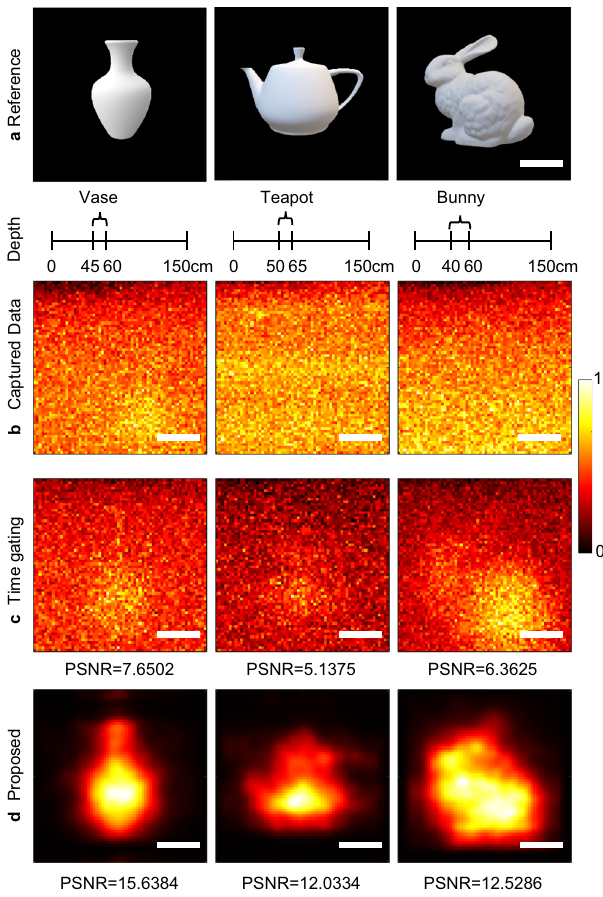
Fig. 6 Comparisons on reconstructing Lambertian objects with complex structures in the fog. a References of 3D Lambertian objects used in this experiment. The total depth of the fog chamber and object depths are marked in the scale below each picture. Taking the ‘ Vase ’ in the fi rst column as an example, the total depth of the fog chamber is 150 cm and ‘ Vase ’ is located at a depth range of 45-60 cm. All scale bars indicate 10 cm. b Images directly captured by the ultrafast detector; c Time-gated results which are taken by combining multiple time-shift bins corresponding to the object depth range. d Reconstructions using the proposed method. PSNR is calculated as the quantitative indicator to compare time gating and the proposed algorithm using the references in ( a ). The results are marked in ( c , d ). PSNR is in